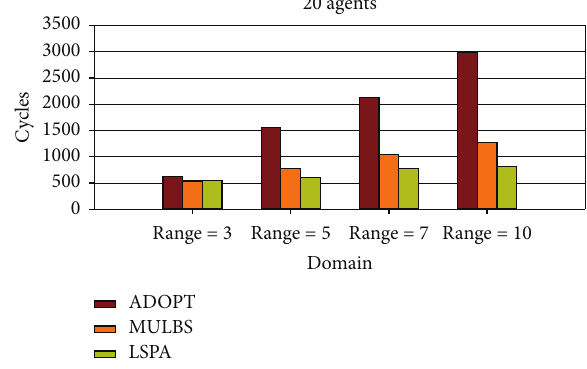
Figure 12: Cycles with density 3 and domains 2, 5, 7, and 10.